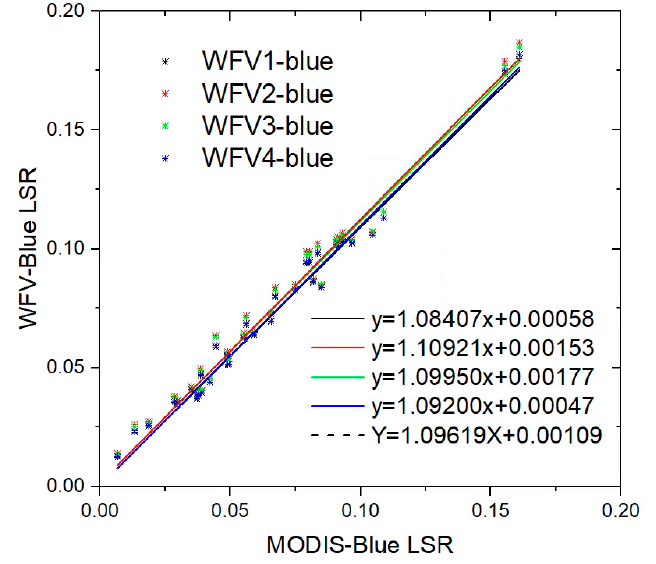
Figure 6. Linear relationships of blue band LSR between MODIS and different WFV cameras of GF-1.